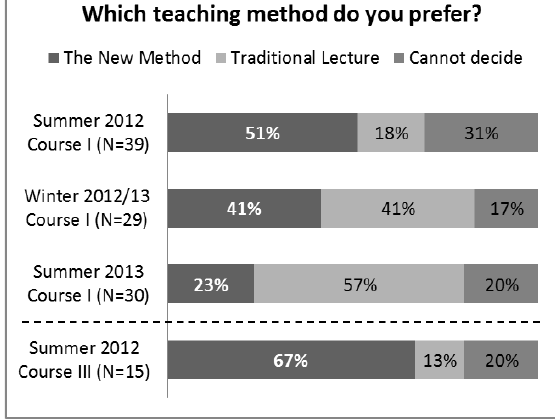
Figure 2. The figure shows the high variation between the cohorts in their opinion on the inverted classroom. The original question was “Alles in allem, welche Form der Veranstaltungsgestaltung würden Sie bevorzugen?“ and the answer possibilities „Die neue Methode“,